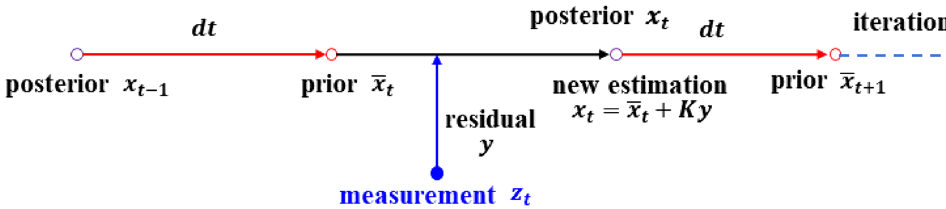
Figure 2. Diagram of the Kalman